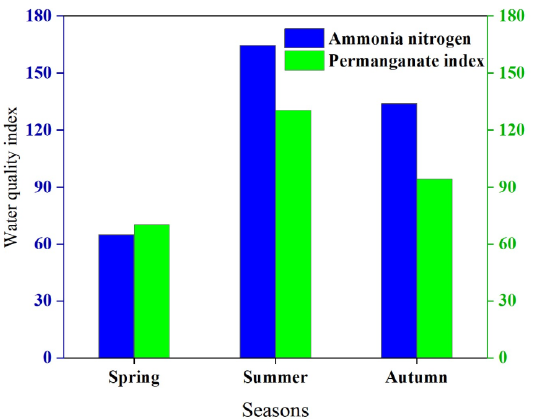
Figure 2. Standard rates by which the Baiyangdian water quality index was exceeded.